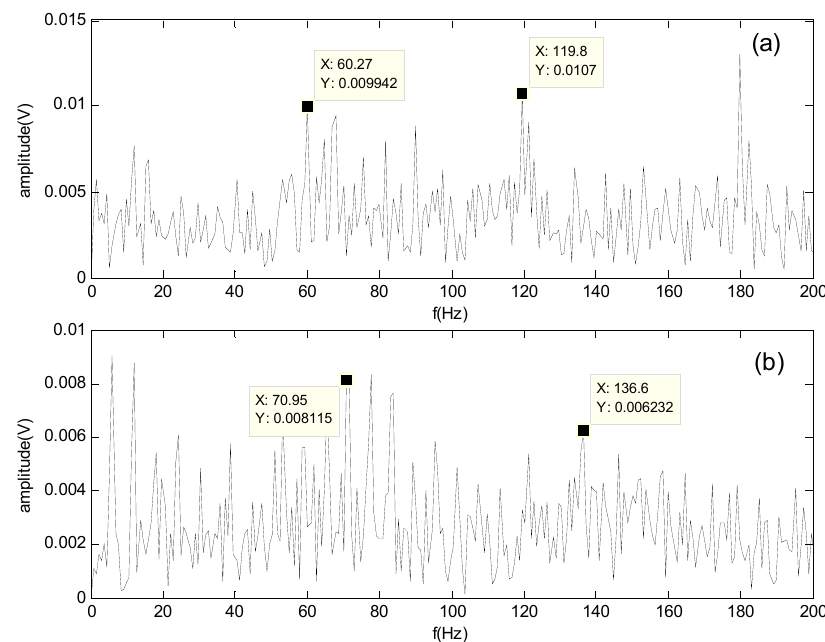
Figure 14. Spectrum of the separated noisy signals by ensemble empirical mode decomposition (EEMD): ( a ) Spectrum of the outer-race defect; ( b ) Spectrum of the roller defect.